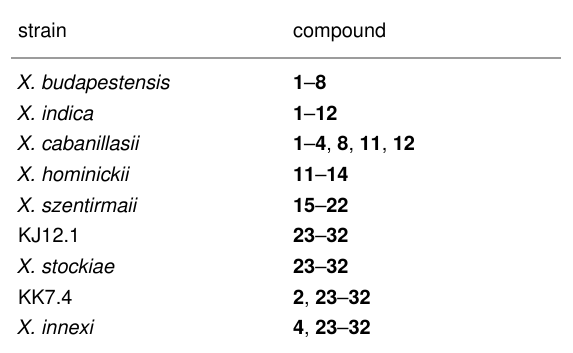
Table 2: Occurrence of the different fabclavine derivatives in the analyzed Xenorhabdus strains. The results are based on the